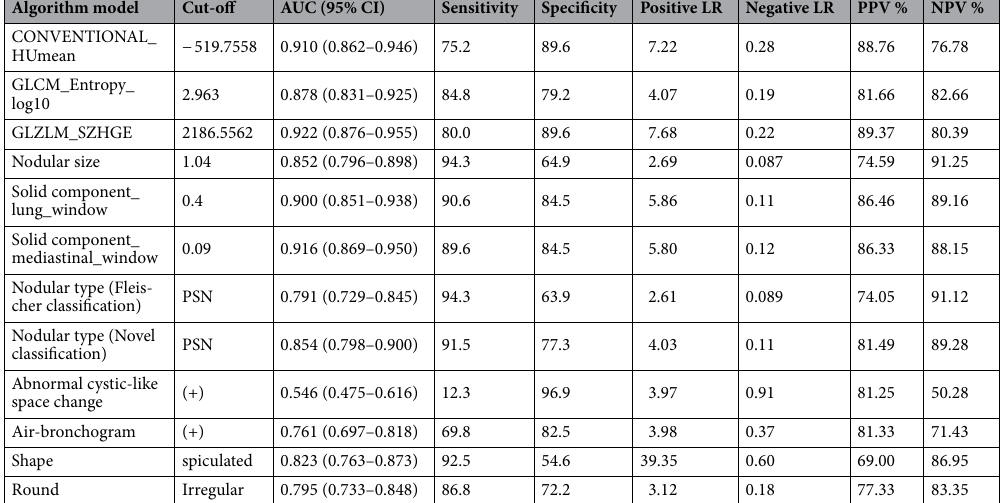
Table 4. The diagnostic performance based on conventional CT features and radiomic features for invasive lesions prediction with SSNs. SSN subsolid nodule, AUC area under curve, HU hounsfield unit, GLCM